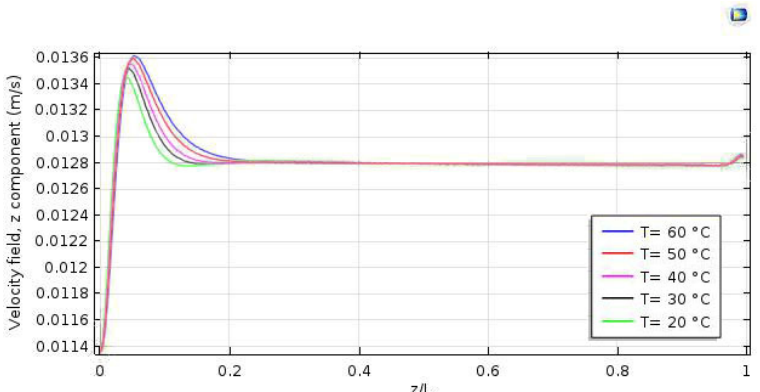
Fig. 17: Velocity profile vs. dimensionless membrane length at different temperatures (3 l/min feed flow rate and 1 bar pressure)